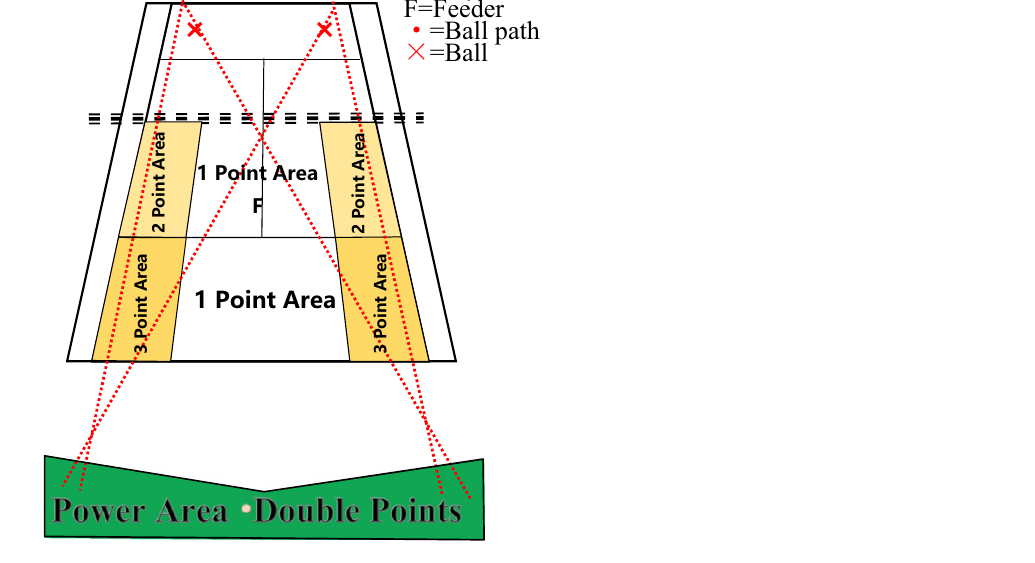
Figure 2. Hitting stability test